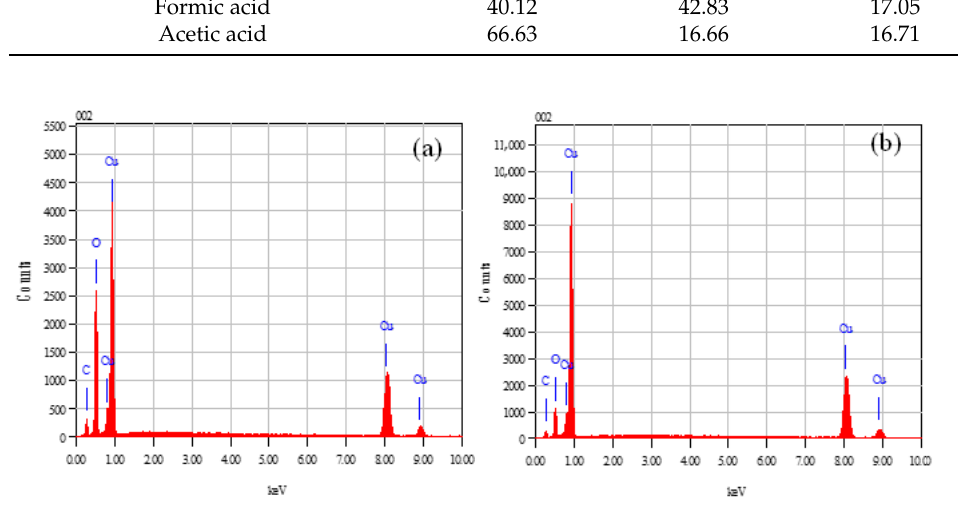
Figure 10. Surface energy spectrum of copper exposed to organic acids for 30 days: ( a ) Formic acid; ( b ) Acetic acid. Table 4. Surface energy spectrum results of copper exposed to organic acids for 30 days (wt%).